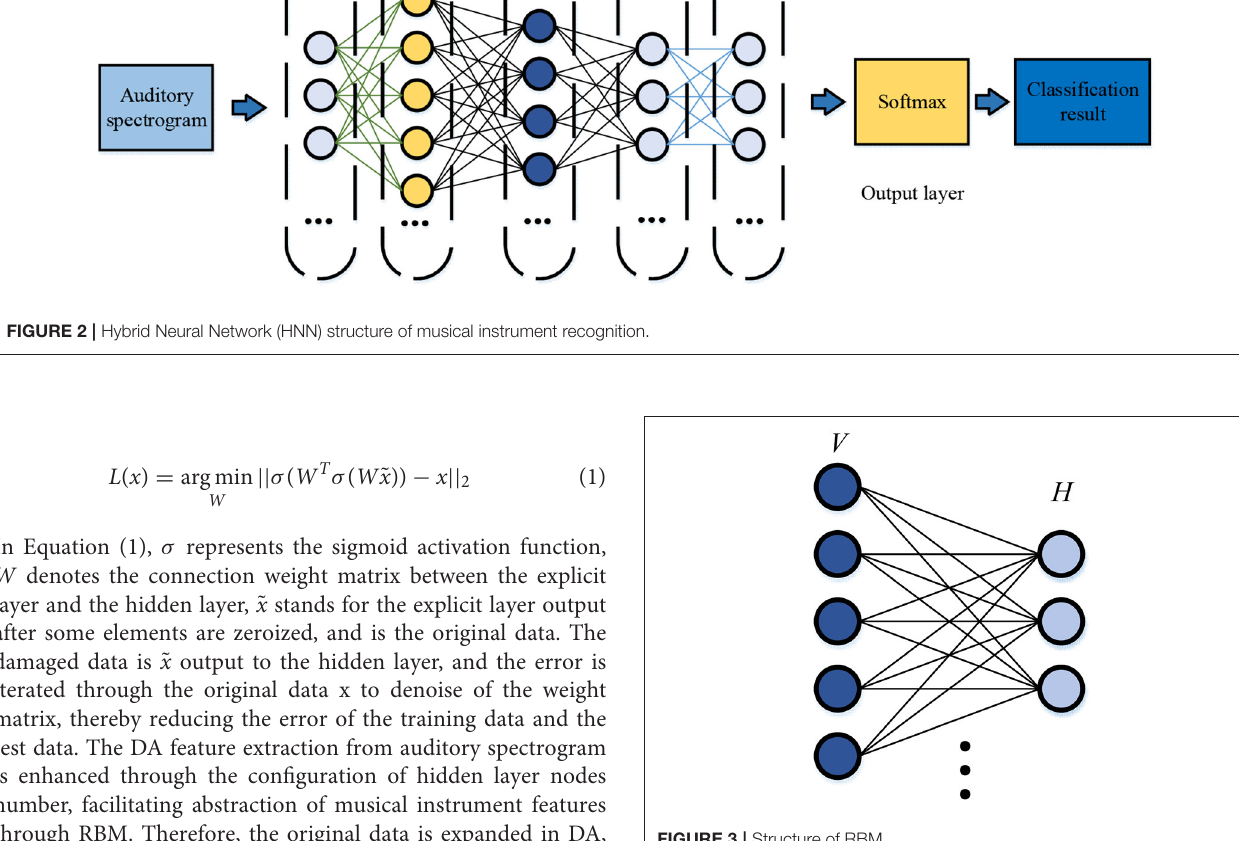
FIGURE 3 | Structure of